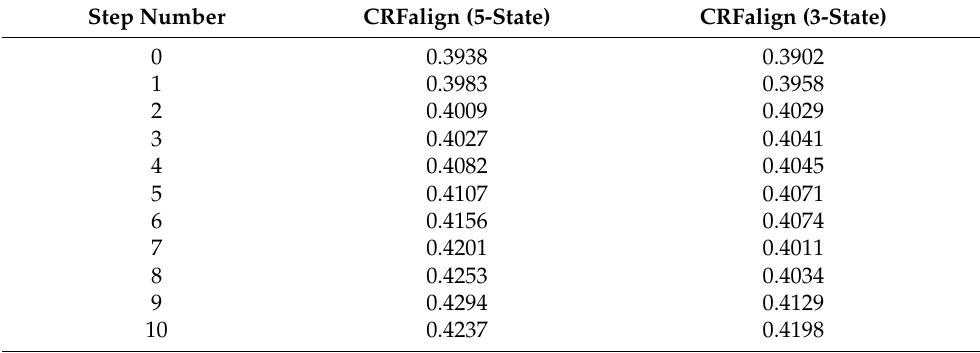
Figure 14. ( Left ) Structure model of d1mwma2 (ParM from plasmid R1 ADP form) based on CRFalign alignment (red) of d1mwma2-d1nbwa3 overlapped with the experimental structure of d1mwma2 (yellow) (with TM score = 0.6182, rmsd = 3.749) and ( right ) that based on Base alignment (cyan) overlapped with the experimental structure (yellow) (with TM score = 0.4829, rmsd = 7.159 ). Table 4. Modeling accuracies in average TM score of 51 pairs involving the CASP14 hard targets based on the five-state model as well as the three-state